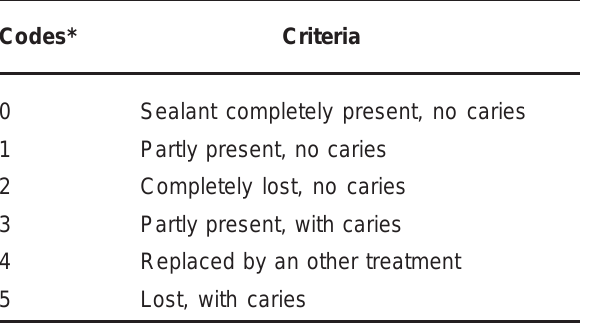
*Success: 0, 1 and 2; Failure: 3, 4 and